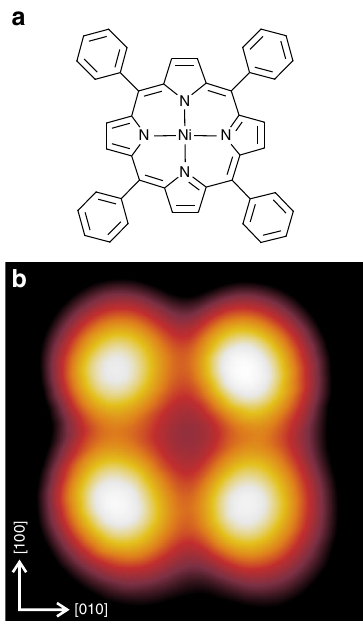
Fig. 1 Ni-TPP molecule. a Chemical structure of Ni-TPP. b STM image of a single isolated Ni-TPP on Cu(100). STM image